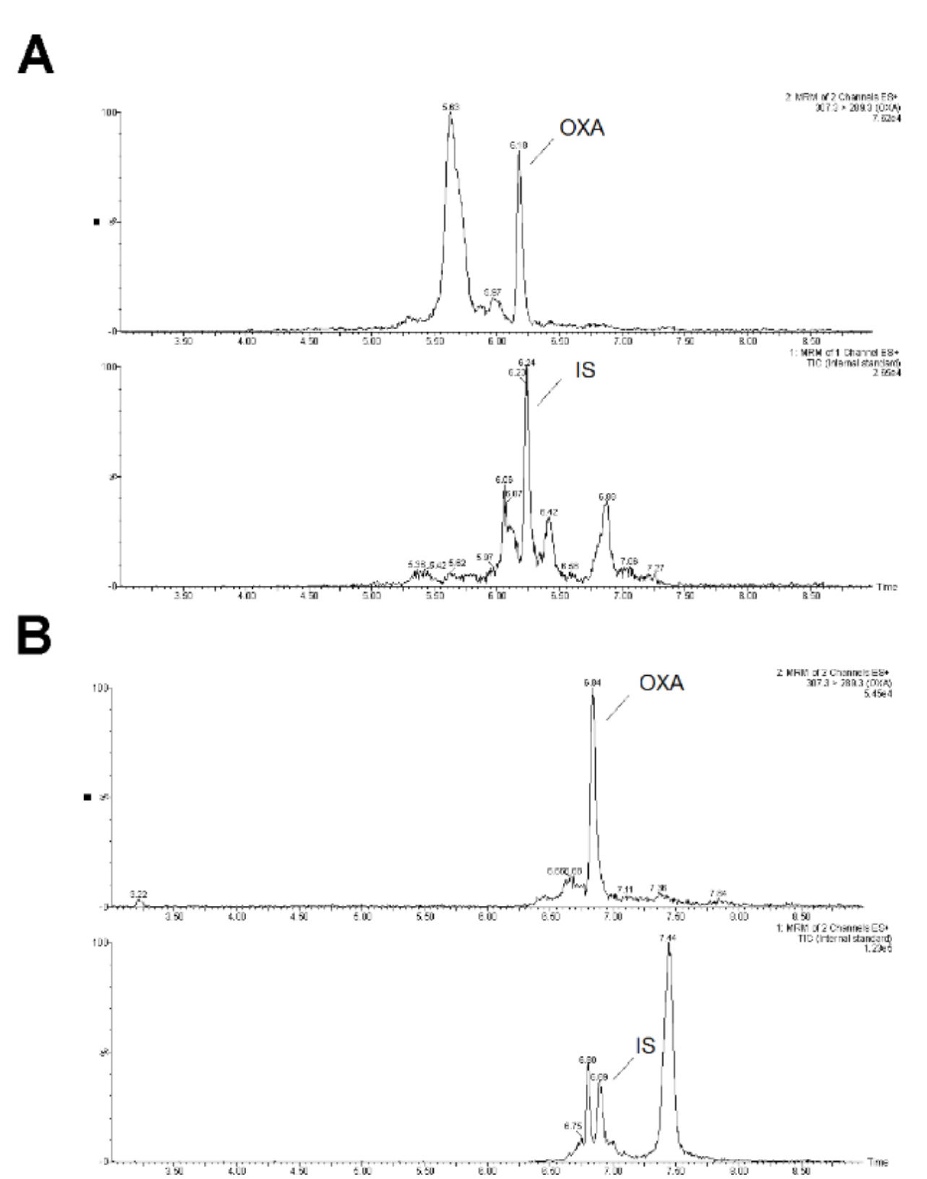
Figure 3. Elimination of urine matrix interferents in the on-line SPE sample pretreatment. Influence of the loading time of the washing solution (30% CAN) on the sample clean-up. MRM chromatogram of oxandrolone (OXA) and methandienone as IS: ( A ) urine spiked with the standard of OXA and IS with the loading time of the washing solution to be 1.5 min, ( B ) urine spiked with the standard of OXA and IS with the loading time of the washing solution to be 3.0